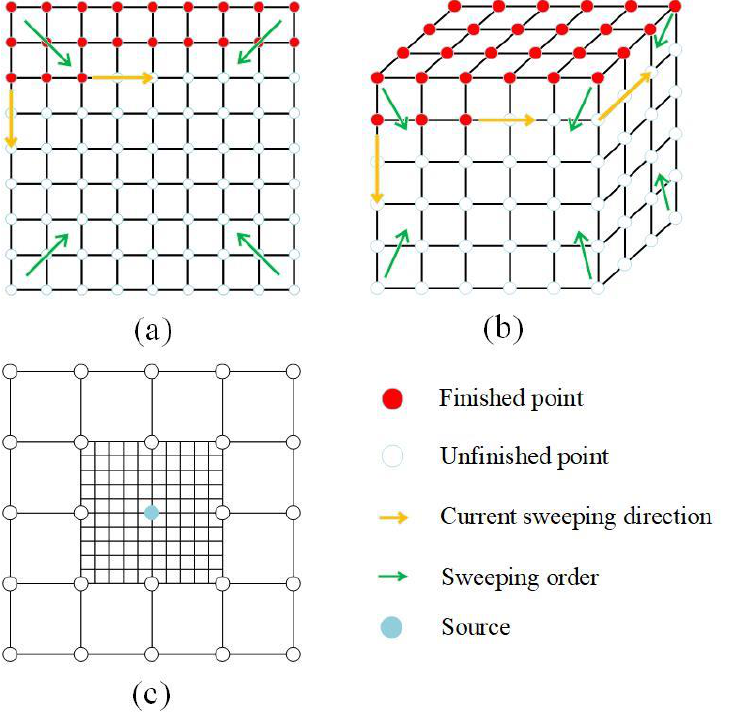
Figure 2. Schematic diagram of fast sweeping method (FSM). ( a ) Sweeping orderings for two-dimensional FSM. ( b ) Sweeping orderings for three-dimensional FSM. ( c ) Improved FSM scheme with mixed grids.